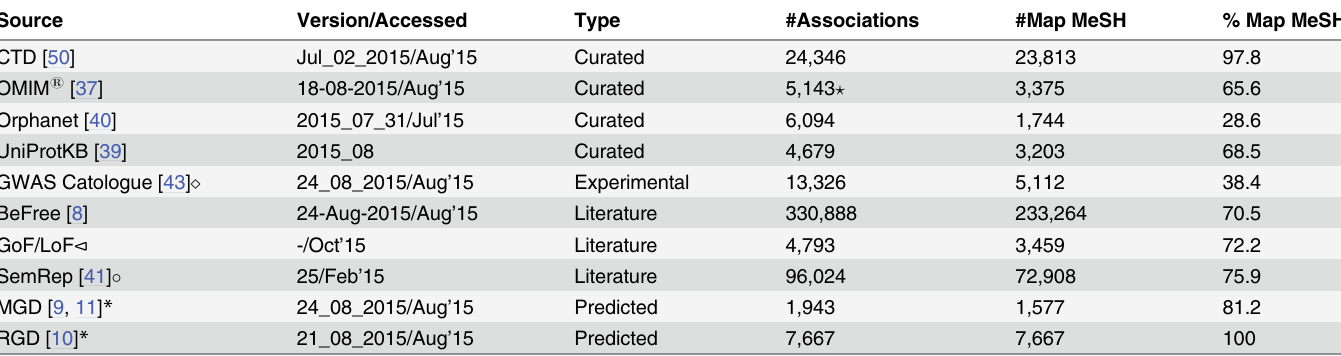
Datasources used for G-D associations. ‘ Curated ’ refers to manually curated associations, ‘ Experimental ’ refers to associations drawn directly from genetic experimental observations, ‘ Literature ’ refers to associations automatically mined from literature and ‘ Predicted ’ refers to associations statistically inferred from animal models. ?